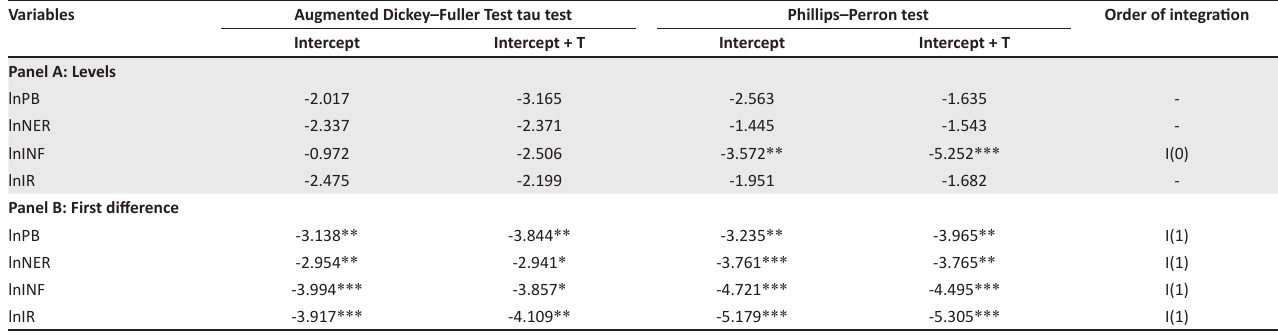
TABLE 1: Results from the stationarity test.